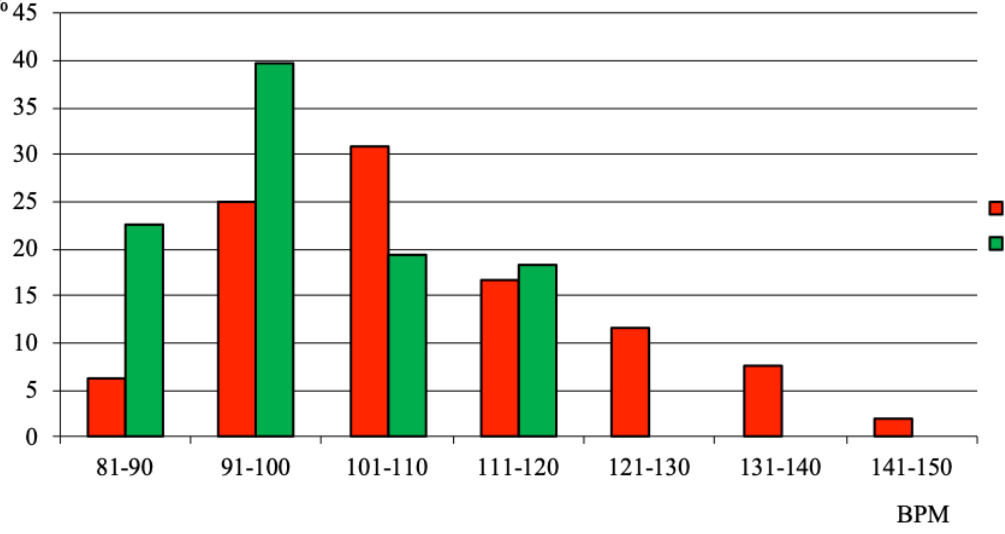
Figure 2. Combined heart rate of a physically weak student during the strength exercises (1 – in the isotonic